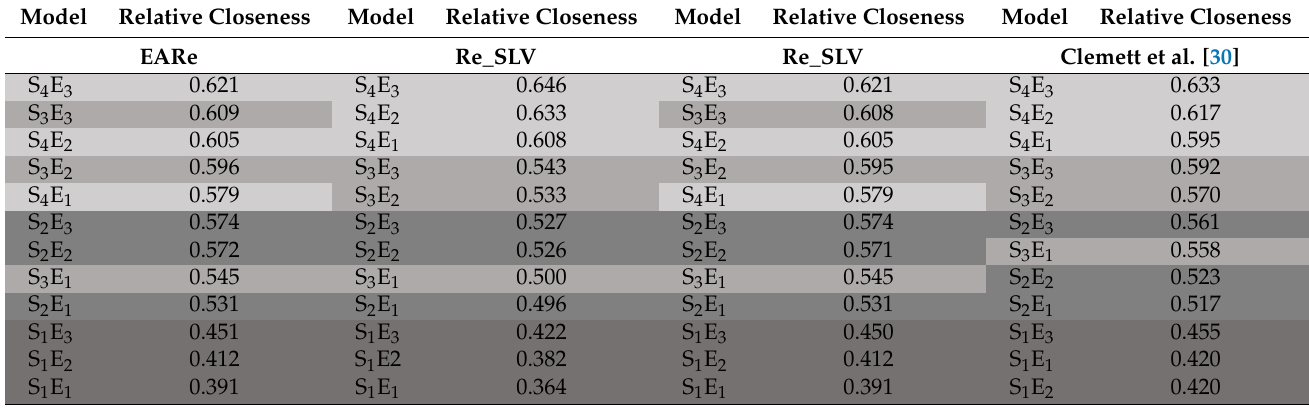
Table 7. Rank using weight vector